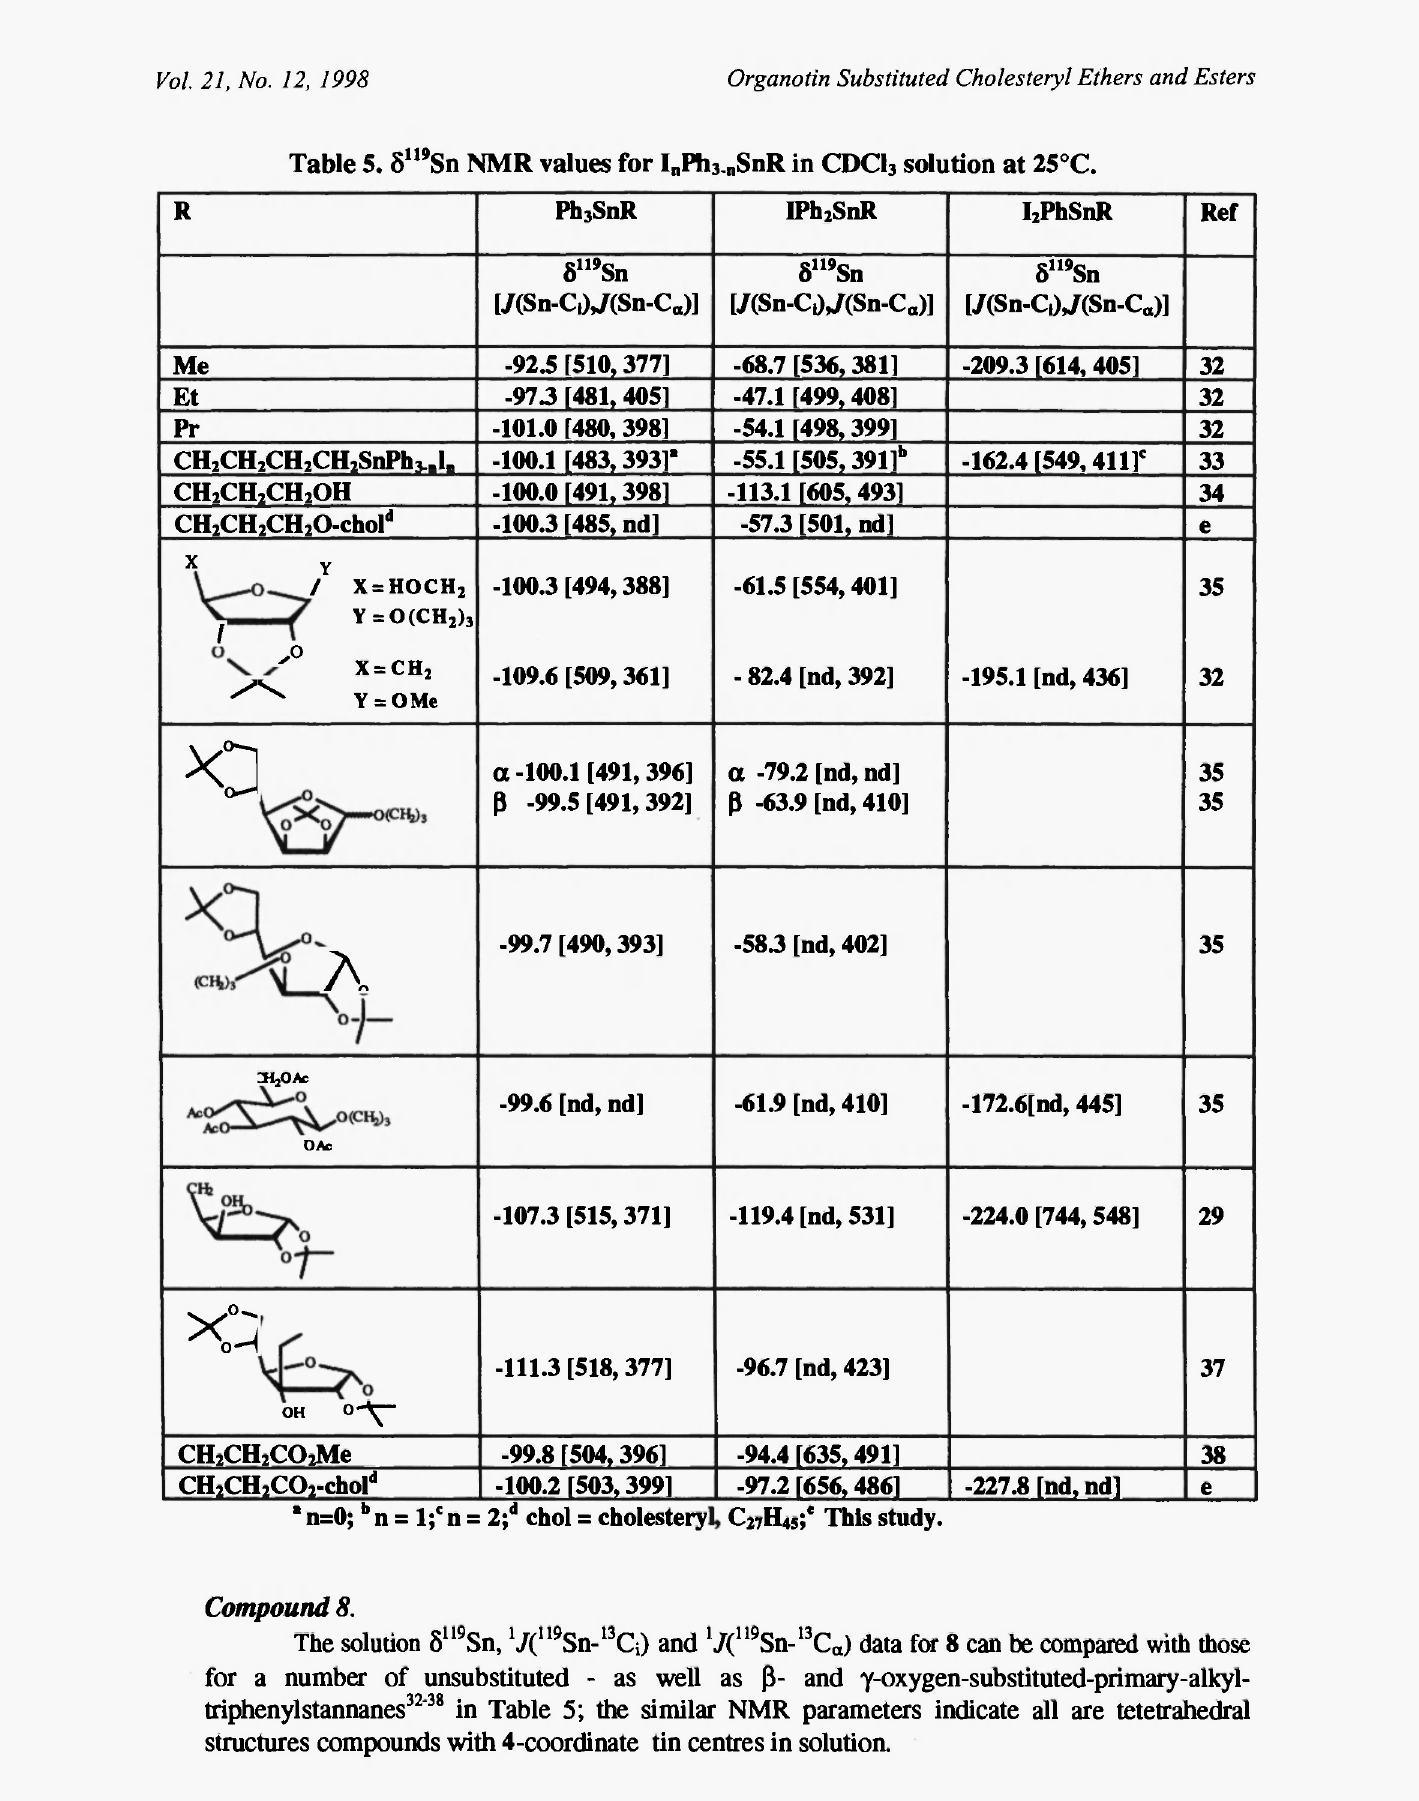
Table 5. 6 U9 Sn NMR values for I„Ph 3 .„SnR in CDC1 3 solution at